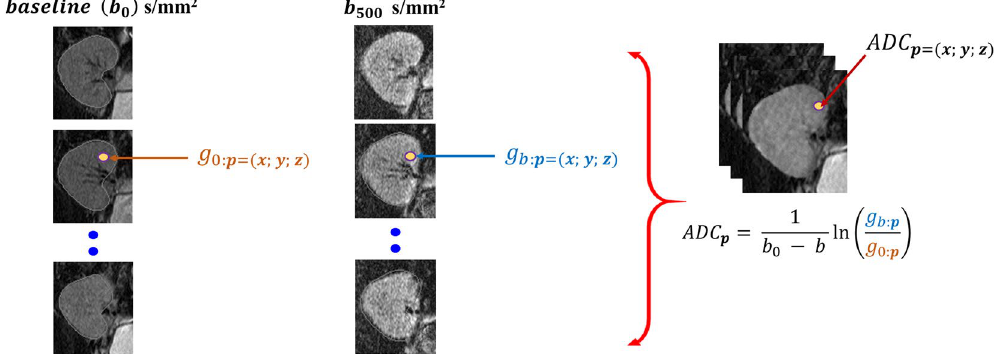
Figure 2. Illustration of the voxel-wise ADC calculations at a voxel (x; y; z) at b-value of 500 s mm − 2 : ( a ) the ROI-kidney regions at b 0 , ( b ) the ROI-kidney regions at b 500 , and ( c ) the constructed ADC maps for the defined